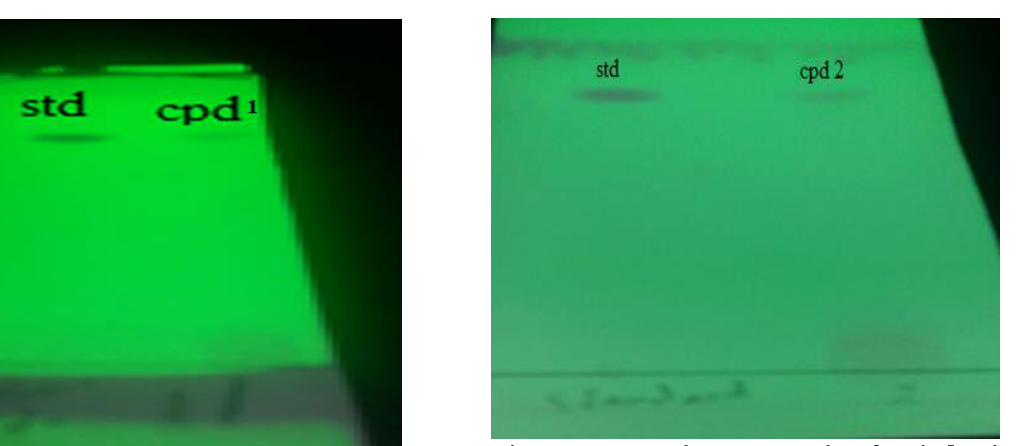
Figurei9. TLC chromatography for isolatede compound number (2) from ethyl acetate fraction and standard S.A using silica gel Gf254 as adsorbant and mobile phase S2.